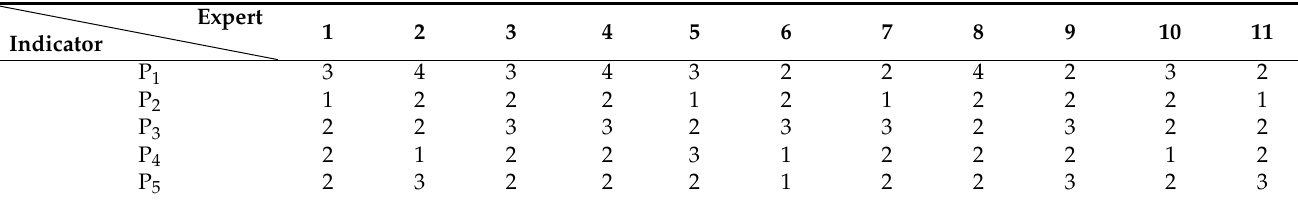
Table A10. Raw data of personnel risk (P).